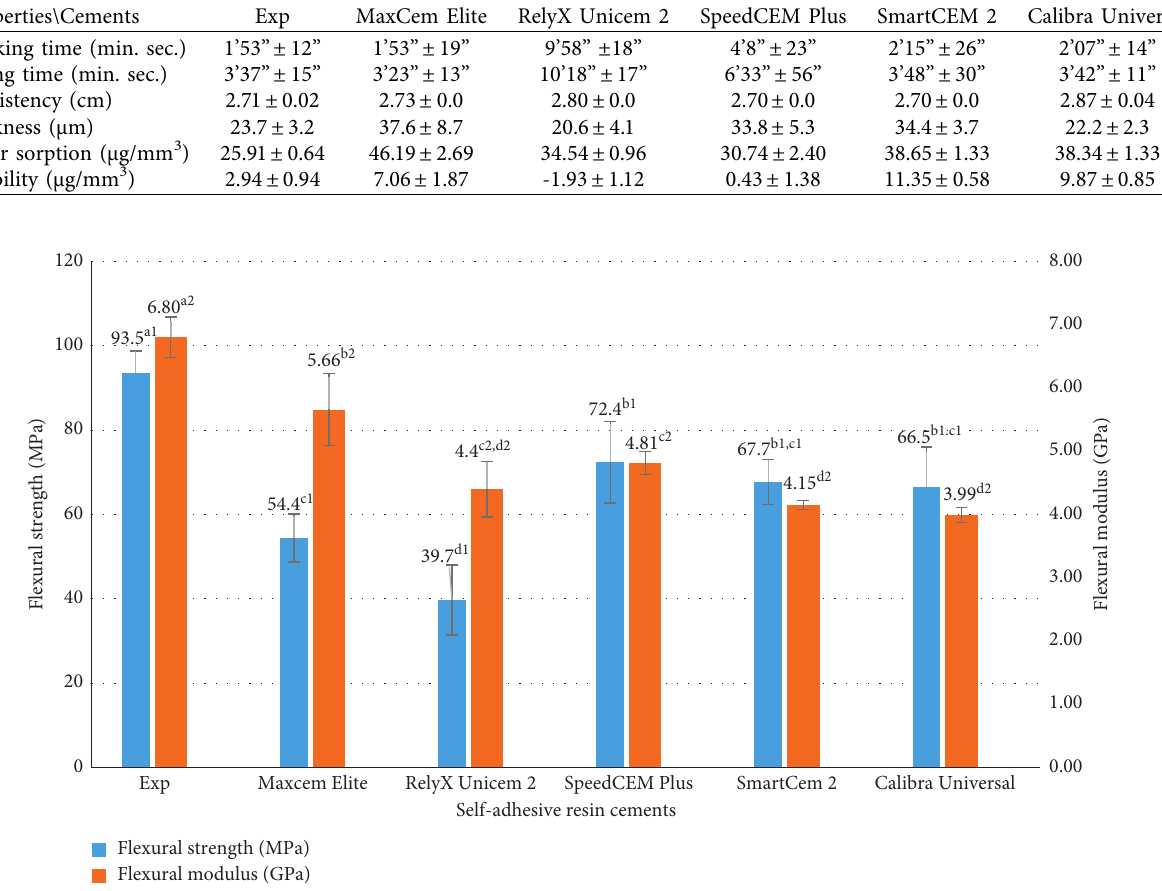
Figure 1: Flexural strength and modulus of self-adhesive resin cements (values with the same superscript are statistically equivalent between the tested